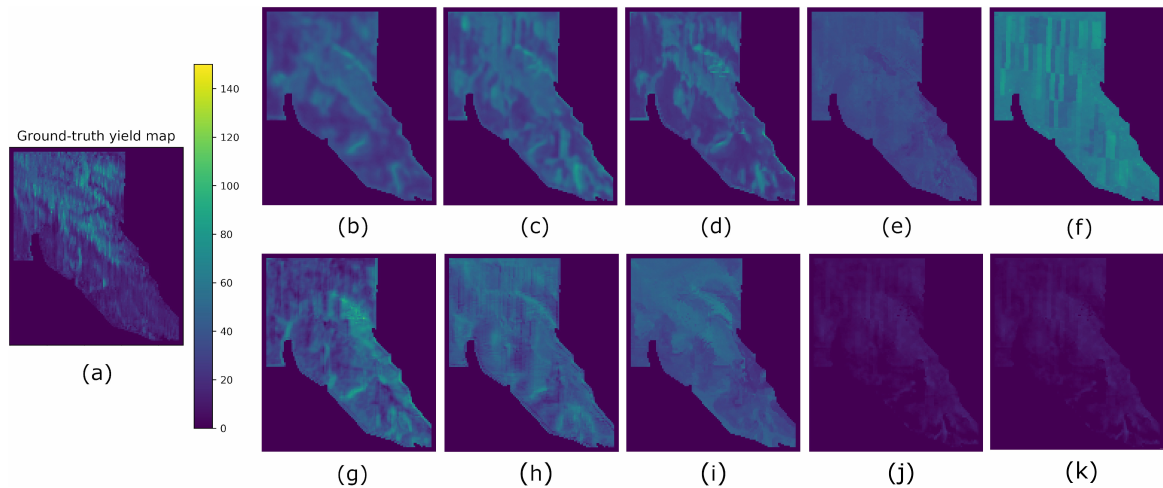
Figure 9. Yield prediction comparison on the G2 field using split A. ( a ) Ground-truth. ( b ) Hy- per3DNetReg ( N = 5). ( c ) Hyper3DNetReg ( N = 3). ( d ) Hyper3DNetReg ( N = 1). ( e ) Ad- aBoost.App. ( f ) SAE. ( g ) 3D-CNN. ( h ) CNN-LF. ( i ) RF. ( j ) BMLR. ( k )